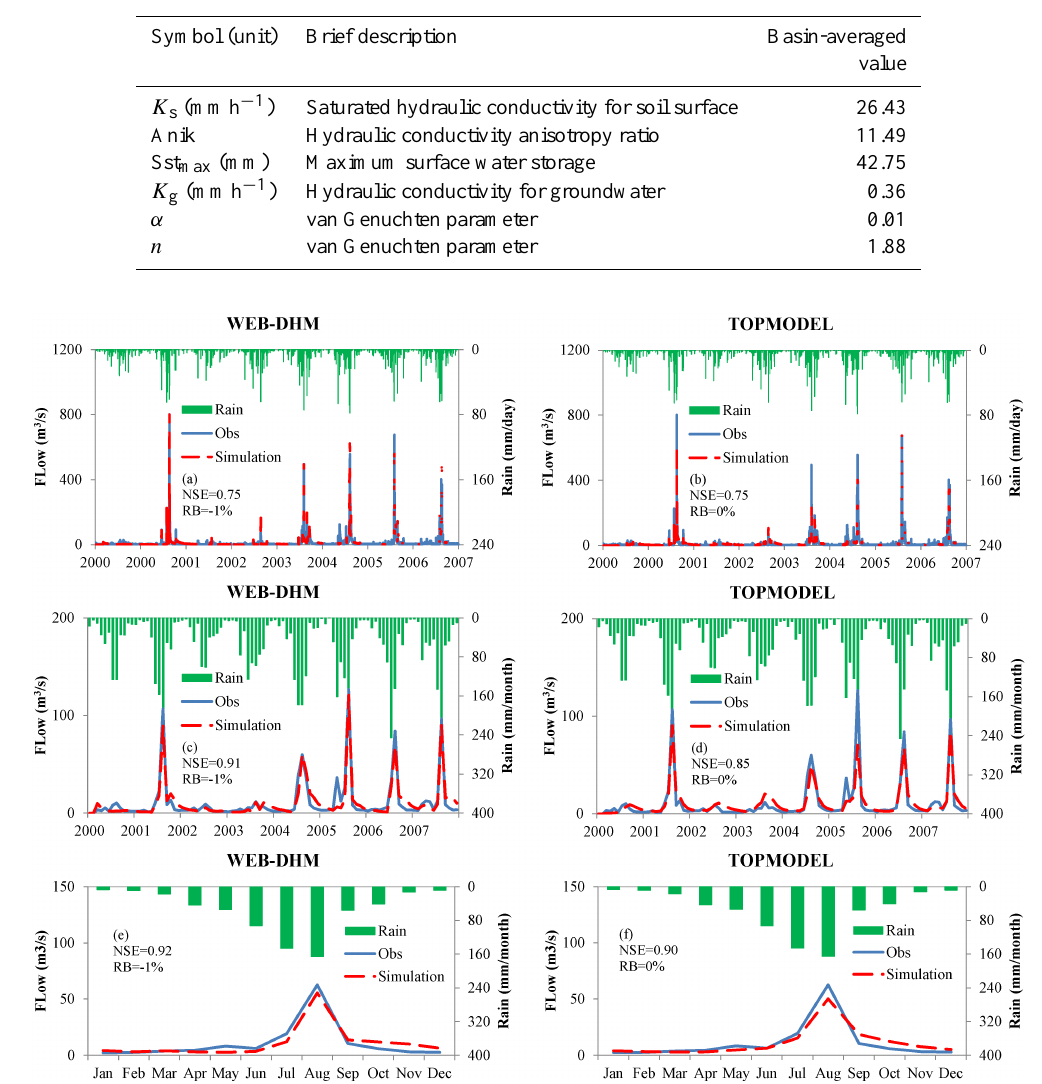
Figure 9. Observed and simulated flows using WEB-DHM and TOPMODEL from 2000 to 2007: (a) , (c) , and (e) are daily, monthly, and inter-annual simulations using WEB-DHM respectively; (b) , (d) , and (f) are daily, monthly, and inter-annual simulations using TOPMODEL